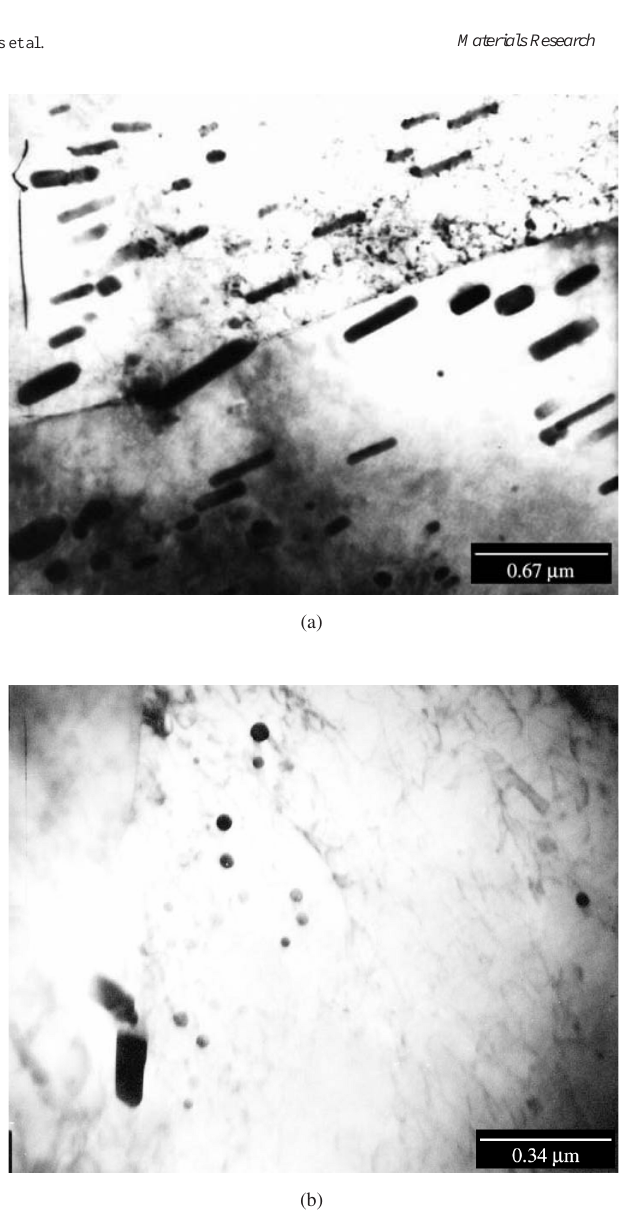
Figure 3. TEM micrographs, a) Al 2024 (30.000X); and b) Al 8090